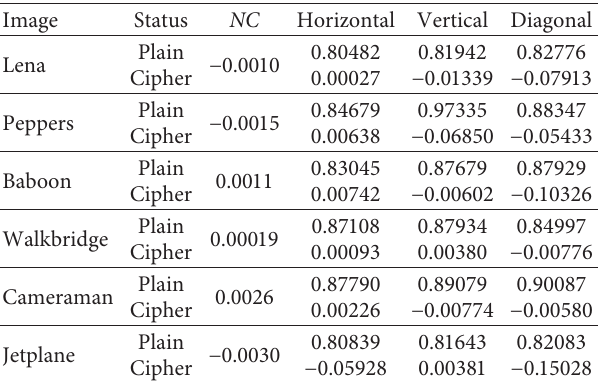
Table 3: ρ and NC values of the original image and its corre- sponding encrypted image.